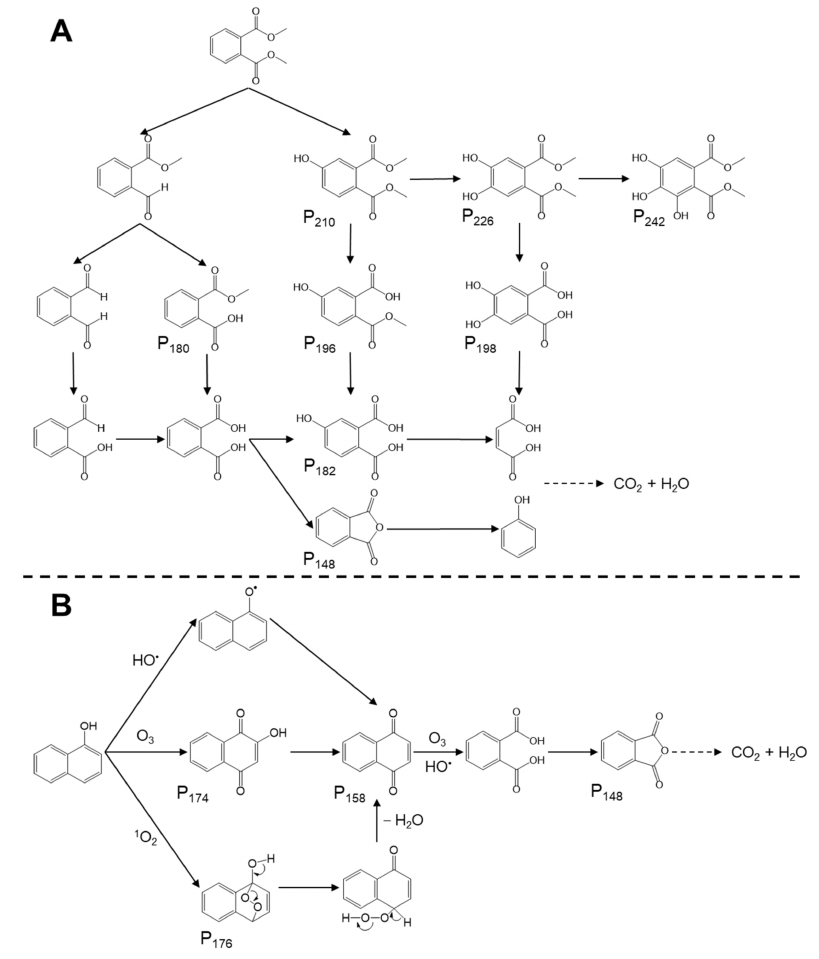
Figure 4. Degradation pathways of DMP ( A ) and 1 − NP ( B ) during Fe/Mn@ γ − Al 2 O 3 catalytic